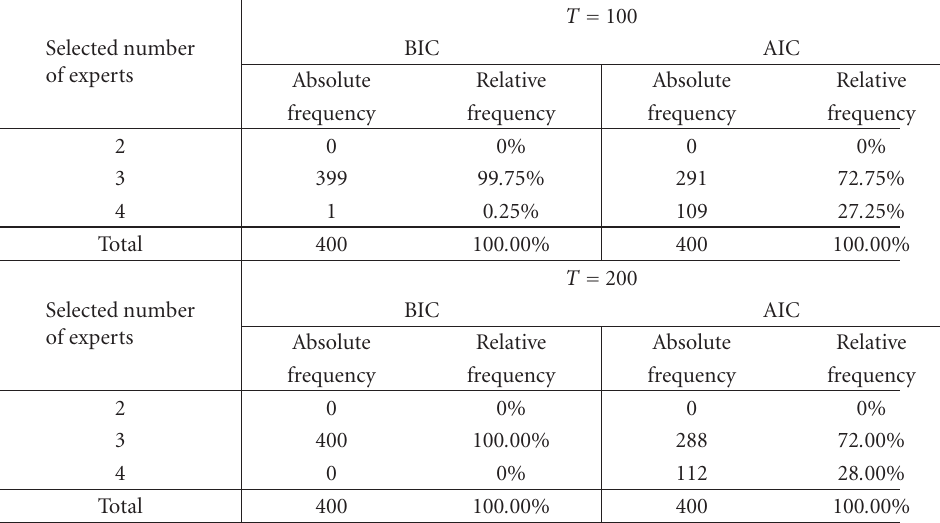
Table 5.2. Mixtures of 3 binomial